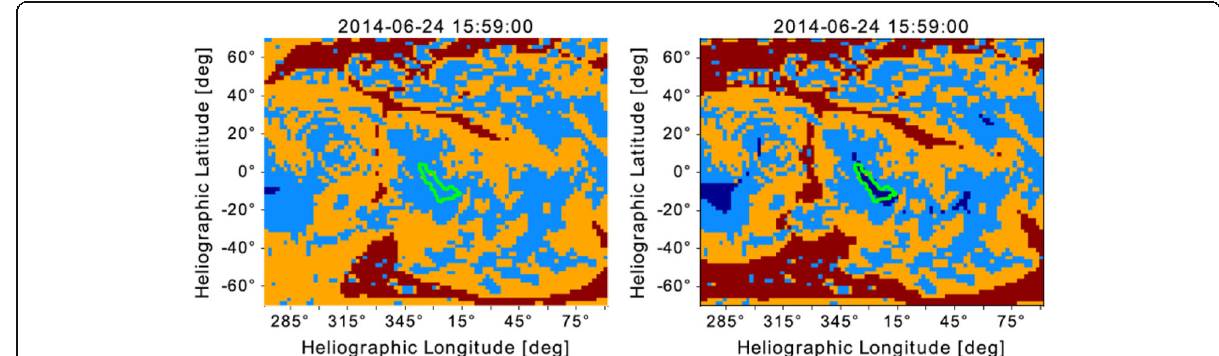
Fig. 35 Maps of open-closed flux generated for the same CH by two different model runs. The one on the left resulted by EUHFORIA running for the default pair of heights [2.3, 2.6] Rs, while the one on the right for the pair [1.3, 1.8] Rs. It is clear that the CH is not present in the model result on the left but is present and well captured by the run setup based on lower heights. This example highlights the impact the heights of the source surface and the inner boundary of the SCS model have in the modeling result. Taken from Asvestari et al.